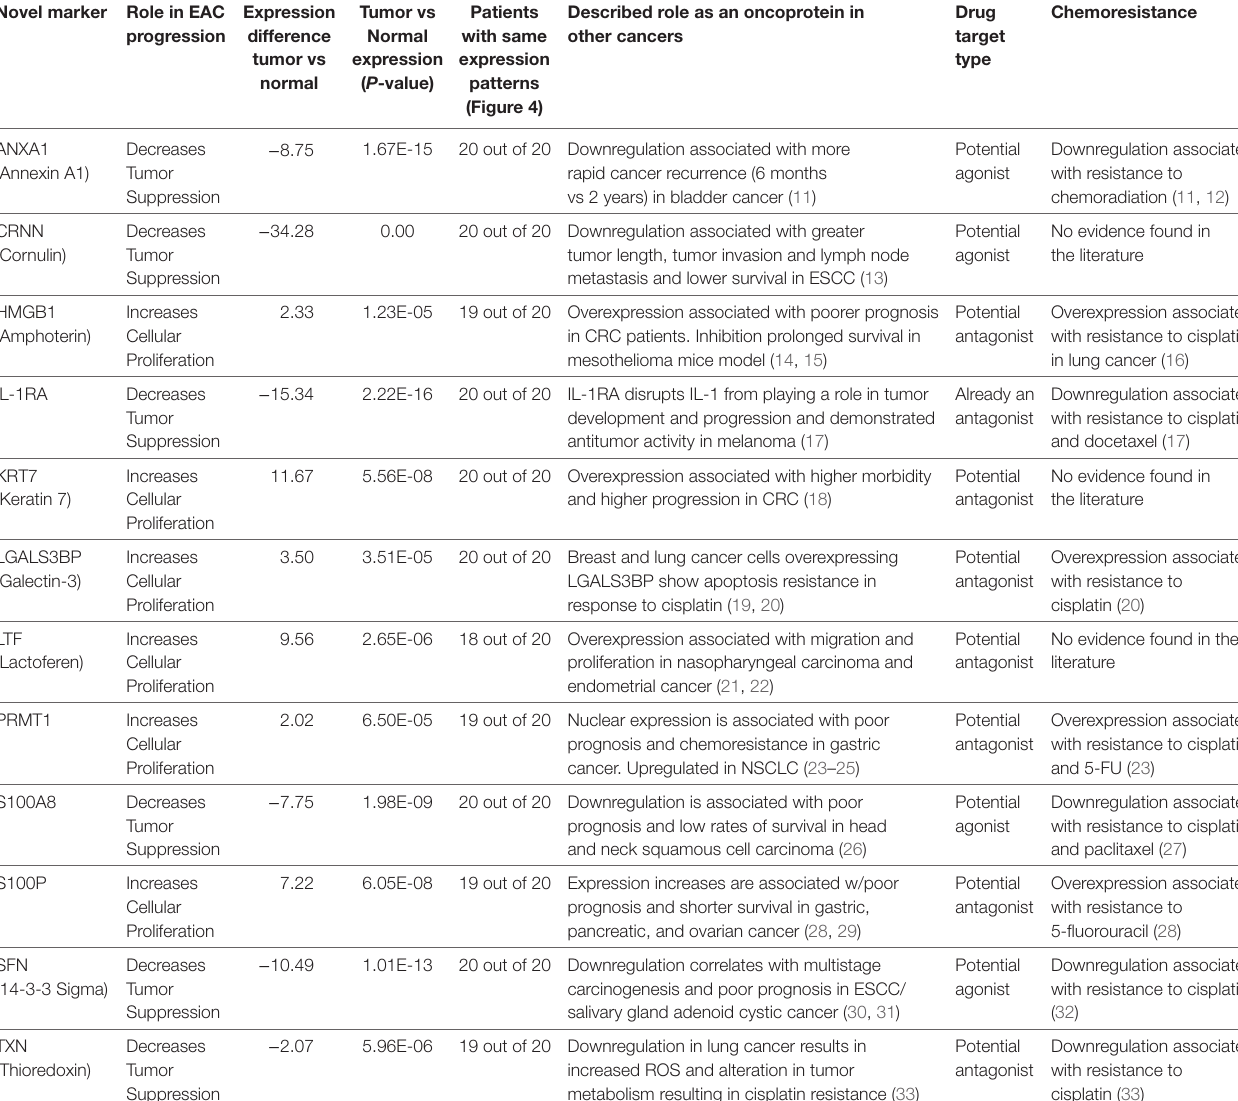
tABLe 1 | Summary of results: details of the 12 novel markers found to be involved in the pathogenesis of EAC. Novel marker Role in eAC expression progression